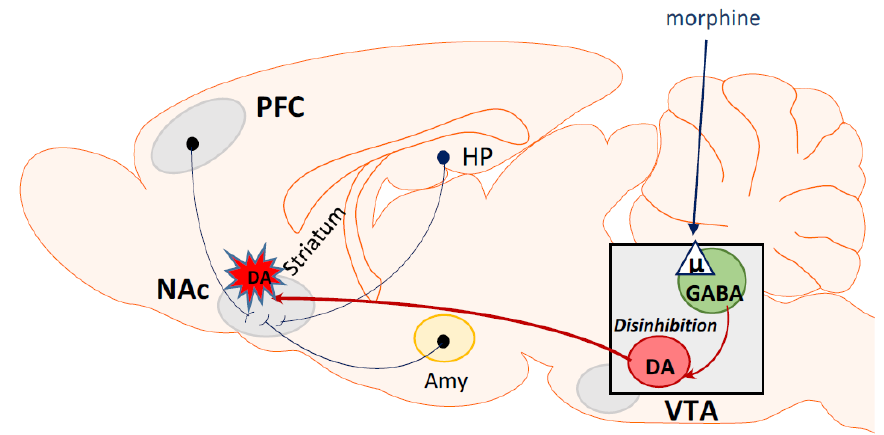
Figure 3. Mechanisms of morphine-induced rewarding e ff ect. The rewarding e ff ect of morphine is associated with stimulation of µ opioid receptors localized at the GABAergic terminals in VTA. It inhibits GABA release and disinhibits dopaminergic neurons in NAc. PFC (prefrontal cortex); NAc (nucleus accumbens); HP (hypothalamus); Amy (amygdala); VTA (ventral tegmental area); GABA (gamma – aminobutyric acid); DA (dopamine).